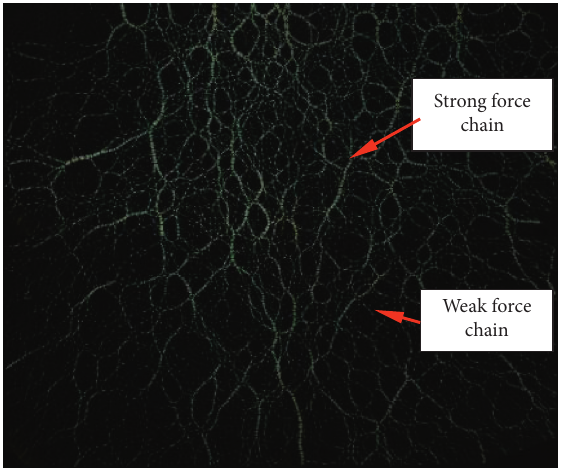
Figure 2: Distribution patterns of the strong and weak force chains within the force chain networks.